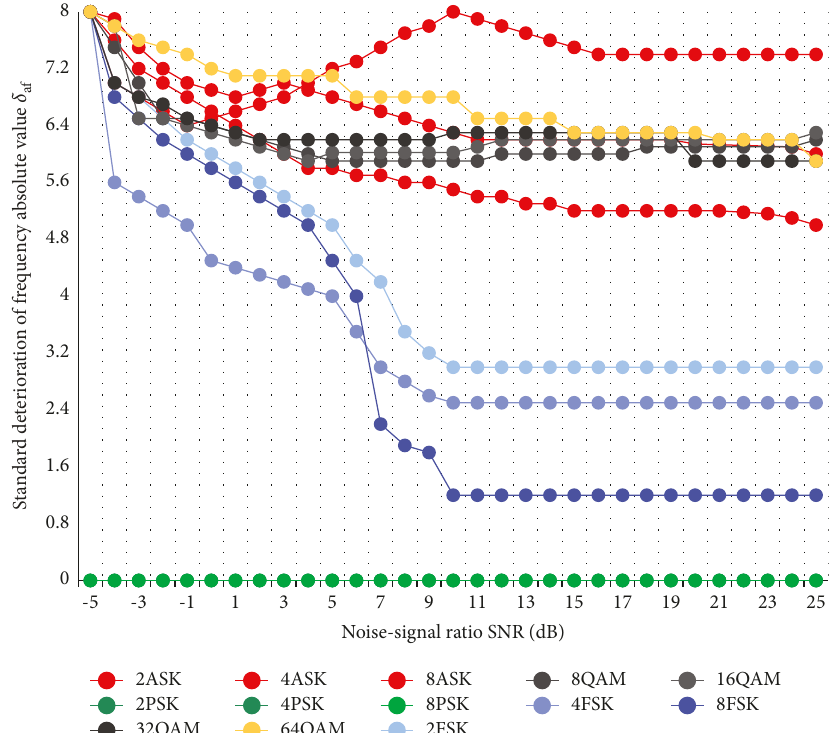
Figure 5: A variation curve of the feature δ af with the signal-to-noise ratio under different social network crisis data methods.